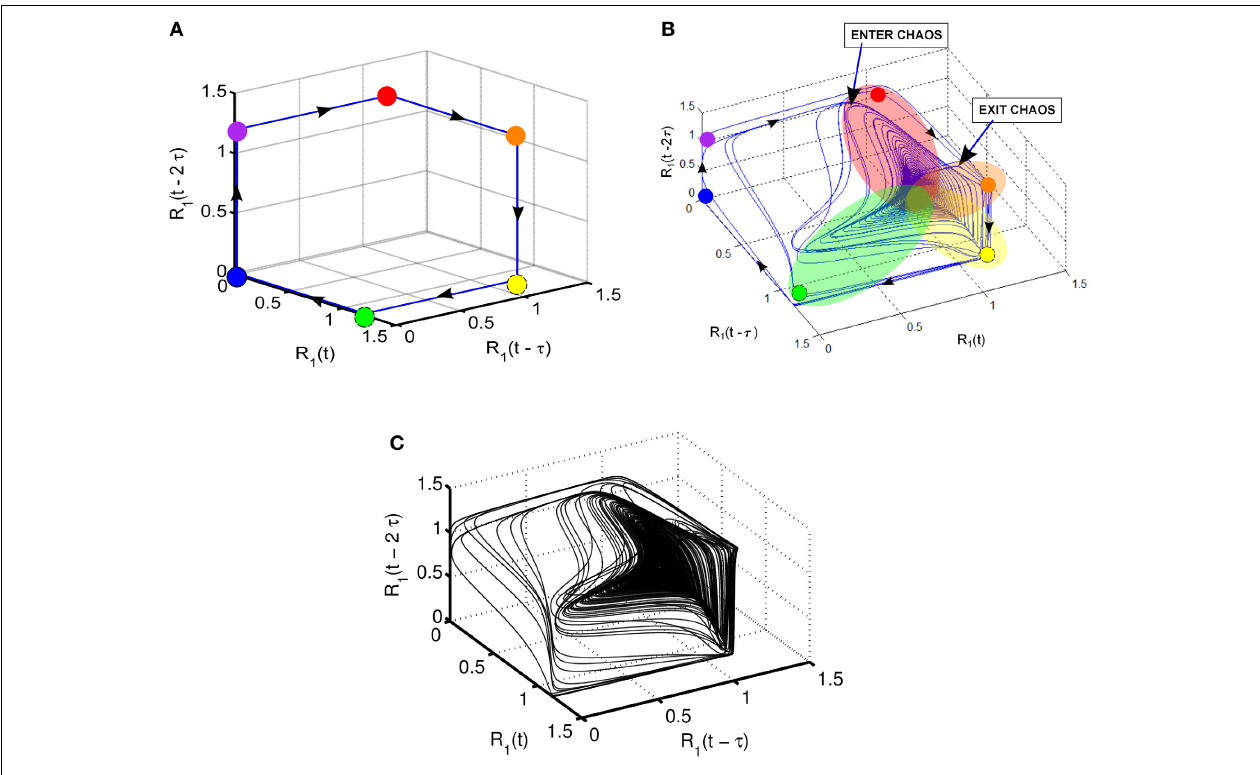
coexistence of SHC and quasi-chaotic attractor—heteroclinic chimera; (C) abnormal regime: coexisting SHC and quasi-chaotic attractor for longer time series with up to 10 5 points.